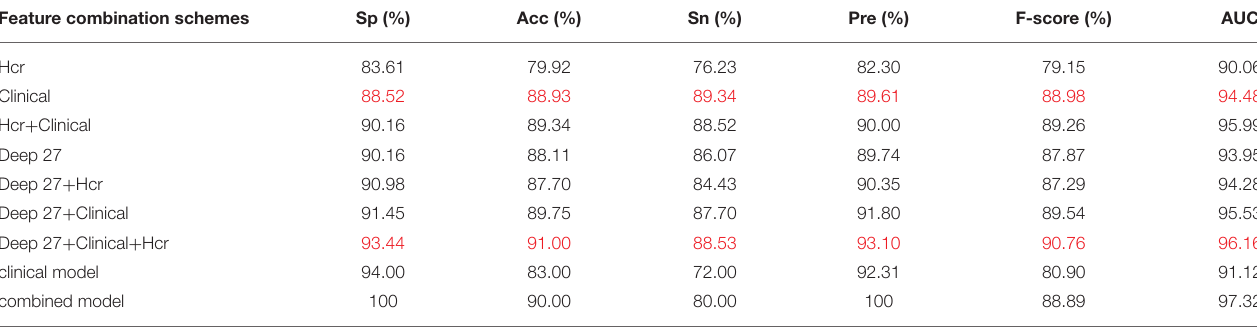
TABLE 5 | Classification performance of different feature combination schemes in test cohort and validation cohort. Feature combination schemes